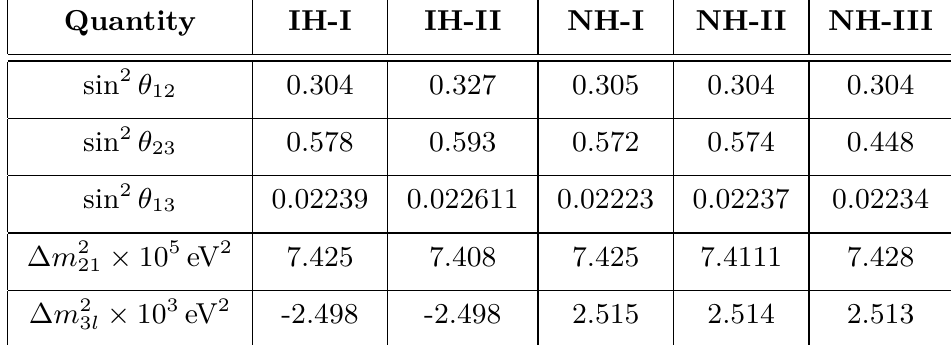
Table 6 . Neutrino mass-squared differences and mixing angles obtained from fits for all the cases studied in this work. Here we have defined ∆ m 2